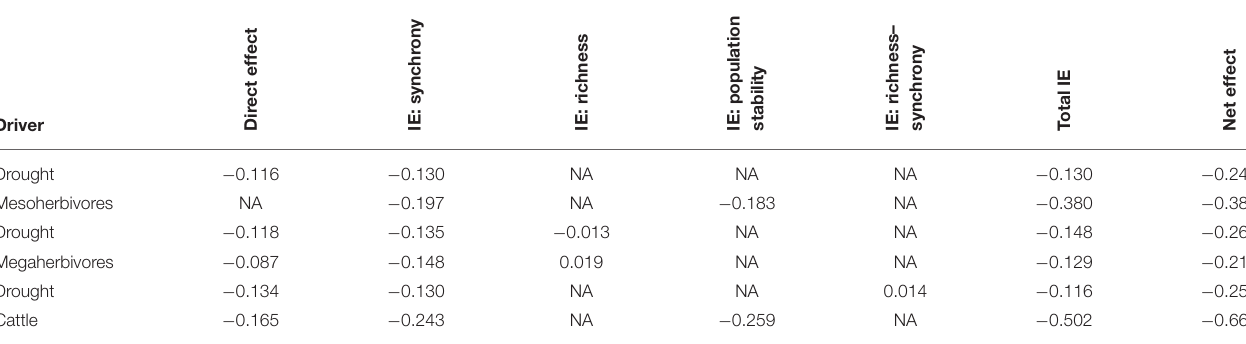
TABLE 5 | Direct, indirect, and net effects of drought and herbivory on stability.